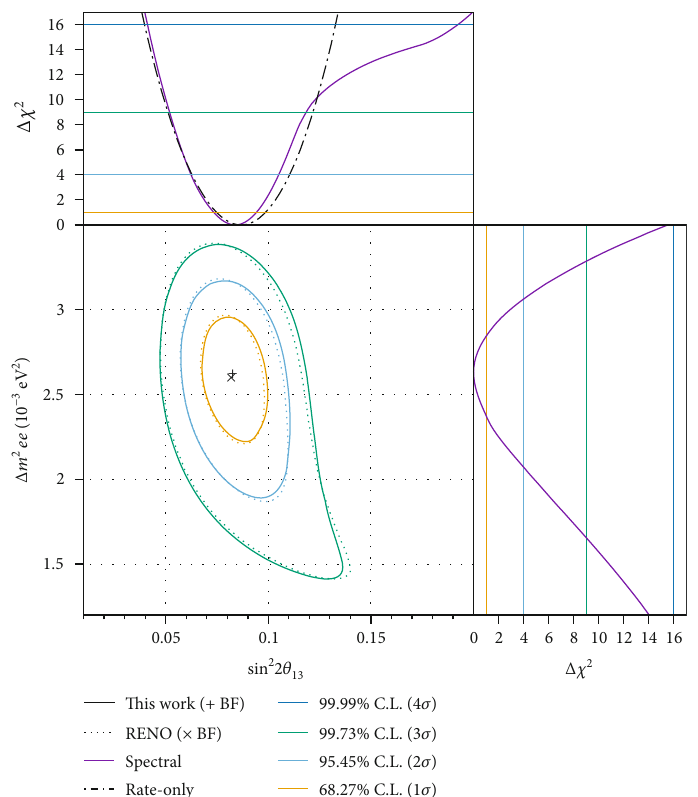
, Δ m 2 Figure 8: Allowed regions in the ( sin 2 2 θ 13 ee ) space at a 68.27%, 95.45%, and 99.73% C.L. from our RENO analysis. The best by a “ + ” in the central plot, where the published RENO contours [25] are also included. The marginalized Δχ 2 over the oscillation parameters are also shown in the upper and right plots, including the rate-only result (dot-dashed line) for the mixing angle, and the 99.99% C.L. line (solid dark blue).